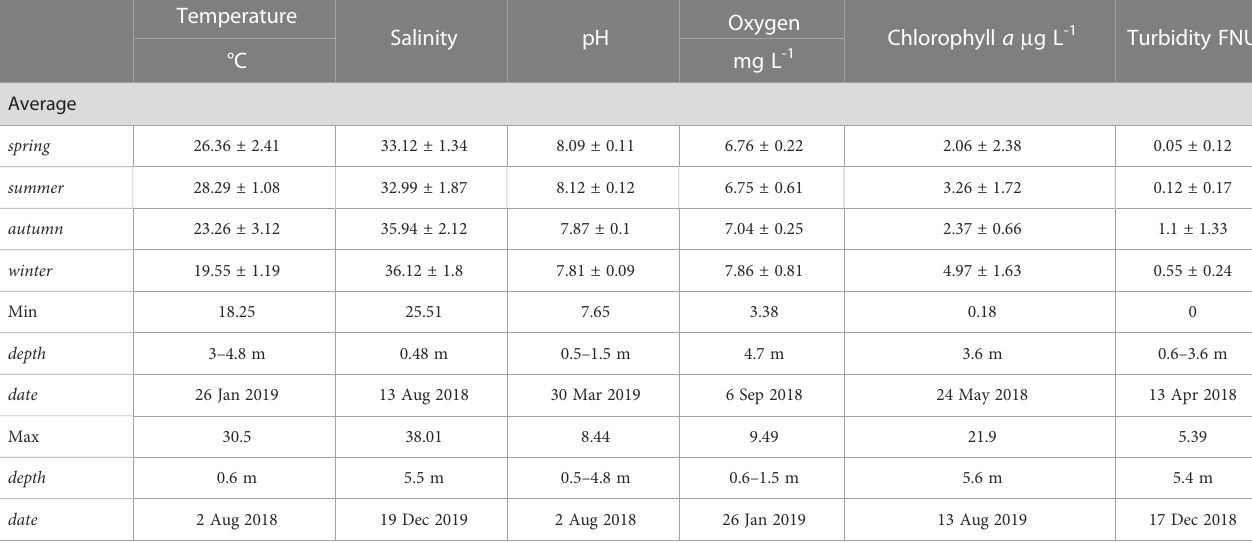
Seasonal average (± SD) and minimum and maximum values observed are